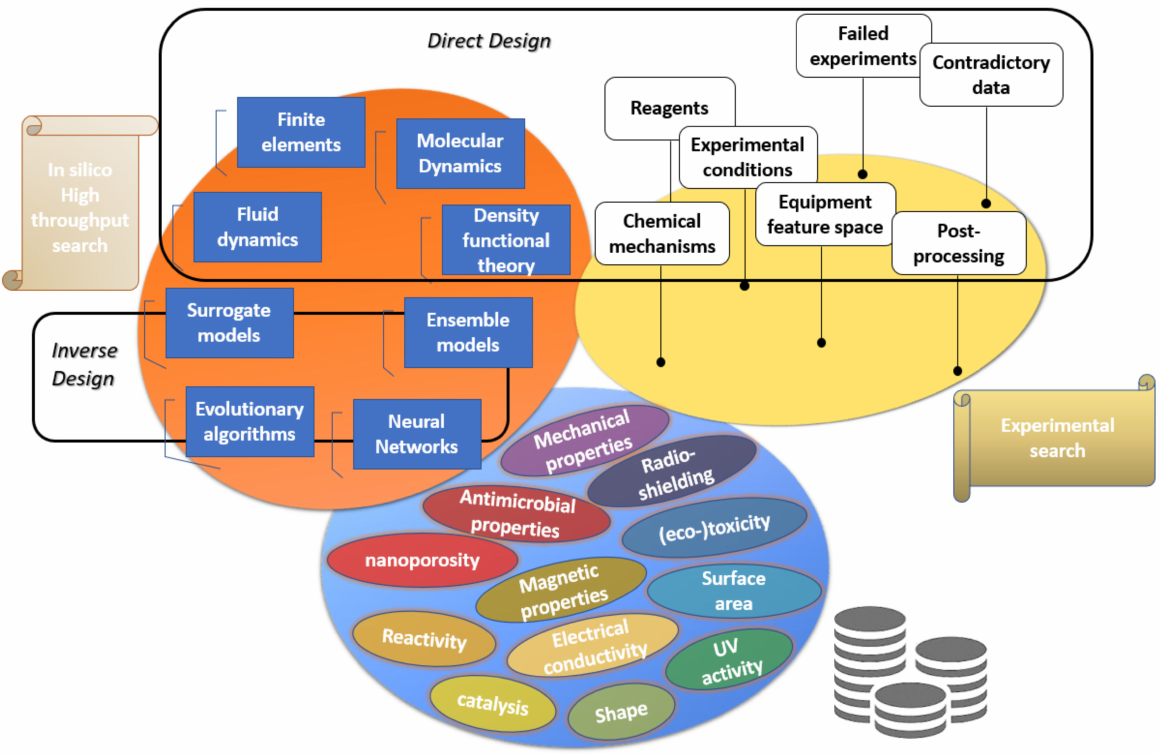
Figure 3. In silico high-throughput material screening and optimization to accelerate materials direct and inverse